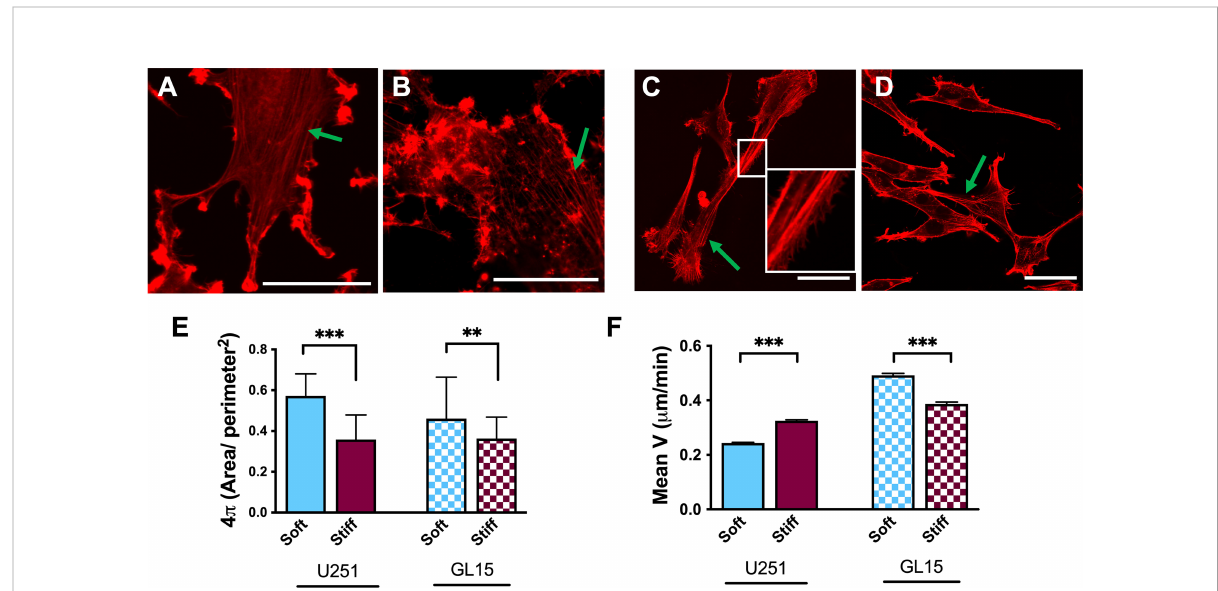
FIGURE 2 Effects of rigidity on cytoskeletal re-organization and motility in U251-MG and GL15 cells. (A – D) Representative confocal images of U251-MG cells stained with phalloidin-TRITC on Soft (A) , and Stiff (B) substrates and GL15 cells on Soft (C) and Stiff (D) substrates. The green arrows indicate stress fi bers. The inset in (c) highlights the presence of pseudopodia along the cell body. Scale bar 50 µm. (E) Quanti fi cation of circularity of U251-MG and of GL15 on different substrates. Data presented as mean ± S.D. (F) Quanti fi cation cell motility of U251-MG and of GL15 on different substrates. Data presented as mean ± S.E.M.; n = 3 independent experiments for each condition. Student ’ s t-test was used for statistical analysis; **p<0.01,